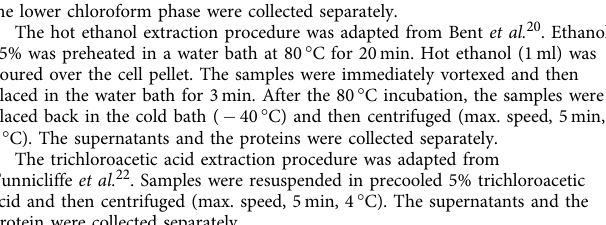
NATURE COMMUNICATIONS|8:15267|DOI: